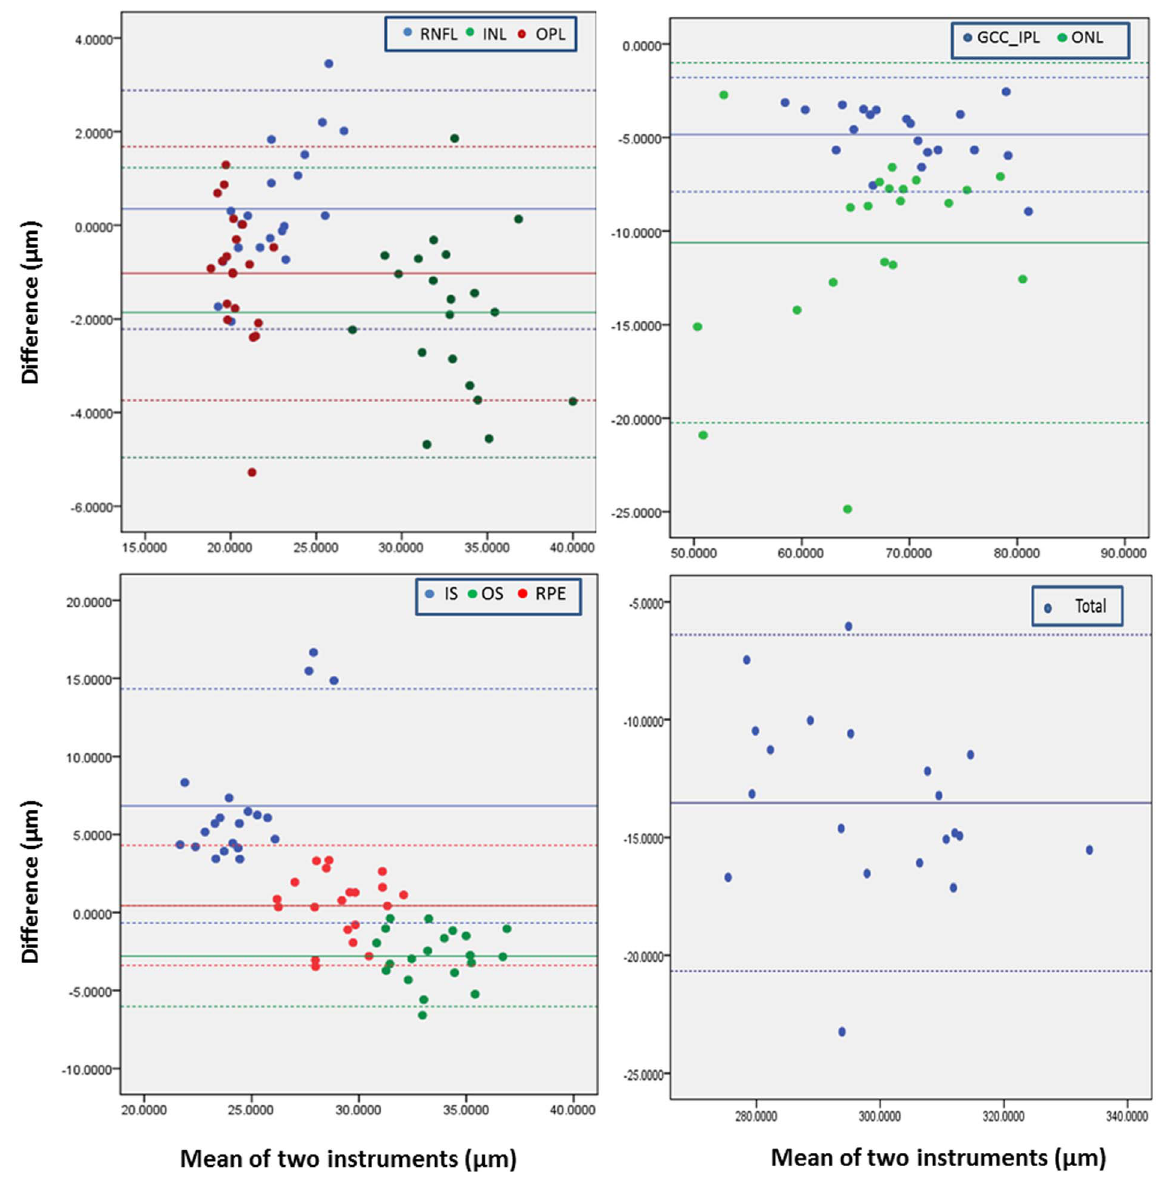
Figure 6. Bland-Altman plots of thickness measurements determined with the automated segmentation algorithm on UHR-OCT and RTVue100 images. Only the images along the horizontal meridian were analyzed. The horizontal full lines represent the mean of thickness differences, and the horizontal dashed lines represent the mean differences 6 1.96 standard deviation.